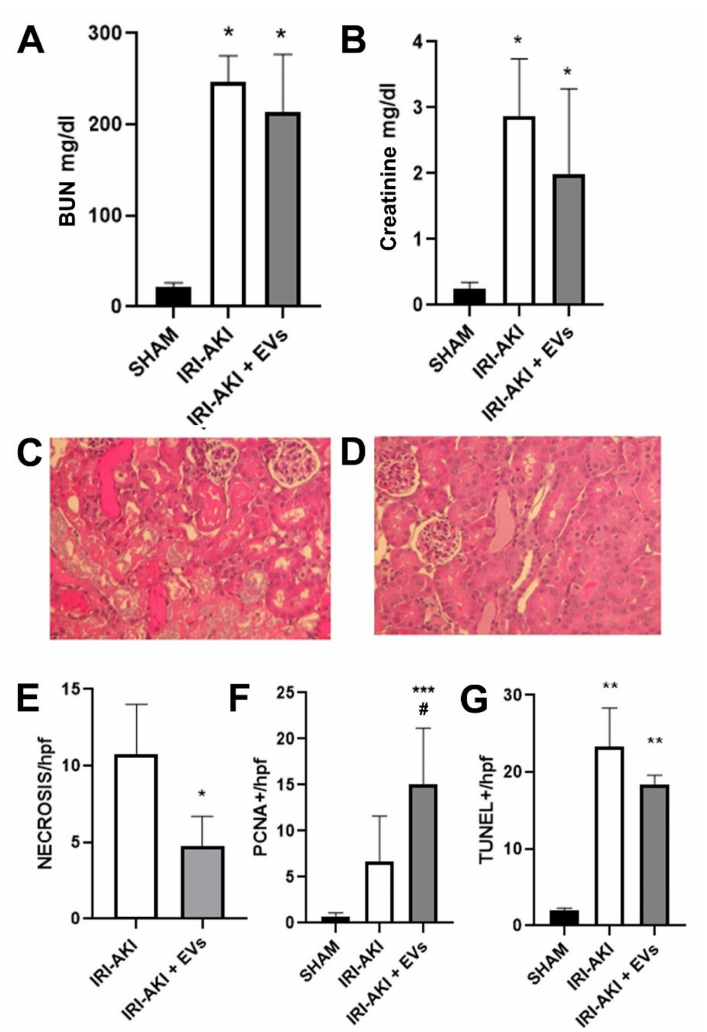
Figure 5. The effects of HLSC-EVs on kidney function and morphology in IRI-AKI mice that